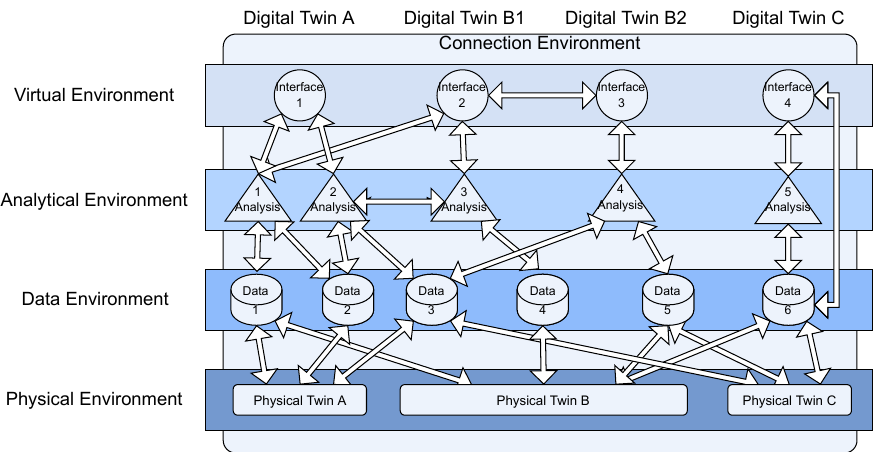
Figure 10. Composition of Components to form Digital Twins. Each DT is represented as a column. The Connection Environment (represented by arrows) connects instances in all environments across DTs. The other environments are aligned in rows to show the implementation across DTs. Instances are shown in each environment as rectangles, cylinders, triangles, or circles. Data from the Data Environment can processed in the Analytical Environment or displayed directly in the Virtual Environment. DTs can also be siloed (e.g., DT C) but more often will use the Connection Environment with complex dependencies across all environments. For example, DT A uses Data 3 and Analysis 3 from PT B. PT B has two DTs where DT B2 is composed into DT B1 in the Virtual Environment by combining interface 2 and 3. DT B1 and B2 use data that is collected from all PTs. Despite DT C being siloed, PT C is evaluated in DT A through Data 3 and Analysis 2. Note that this abstraction makes no claims about the mode of data collection in the Physical Environment that may be with either local sensors or remote sensing. Generated with